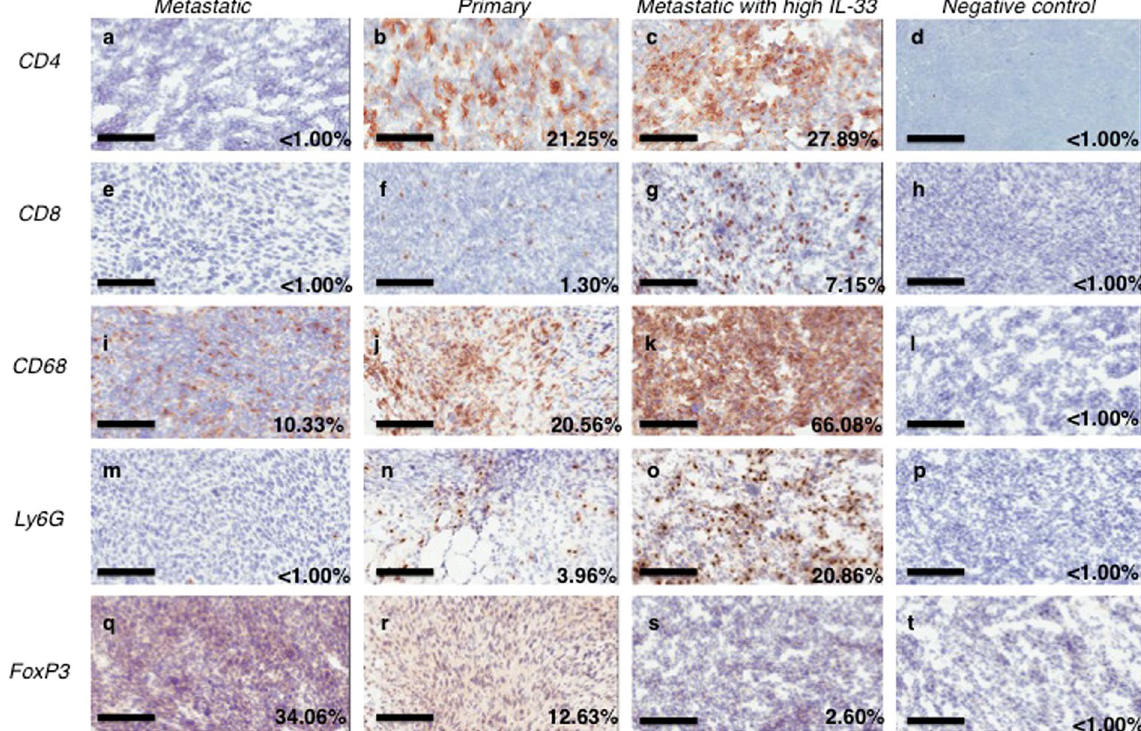
Figure 2. Genetic complementation of immune evasive tumours shows a clear phenotypic shift towards immune recognition. Immunohistochemical staining was used to visualise tumour infiltrating immune cells. CD4 is a glycoprotein found on the surface of T helper cells, macrophages, dendritic cells. CD8 is primarily a marker for cytotoxic T cells, but also found on natural killer cells and DCs; CD68 is a marker of monocytes and macrophages; Ly6G is a marker for neutrophils; FoxP3 is a marker of regulatory T cells. Greater numbers of CD4 + and CD8 + cells can be seen within ( c , g ) the genetically modified (metastatic A9 + IL-33) tumours versus unmodified metastatic (A9) tumours ( a , e ). Fewer regulatory T cells are present in IL-33 expressing tumours, as indicated by lower FoxP3 staining; metastatic A9 ( q ) versus metastatic A9 + IL-33 ( s ) or primary TC1 ( r ) tumours. Increased macrophage and neutrophil responses are seen in IL-33 expressing tumours: unmodified metastatic A9 ( i , m ) versus metastatic A9 + IL-33 ( k , o ) or primary TC1 ( j , n ) tumours respectively. ( d , h , l , p , t ) Negative controls (rat IgG targeting Keyhole Limpet Hemocyanin (KLH)) were included to show that non-specific staining was minimized. The percentage of positively stained cells was calculated from the total number of cells on each slide. 10 µ m thick sections were stained with appropriate antibodies and imaged at 20X magnification ( a – t ); size bar = 100 µ m ( a – t